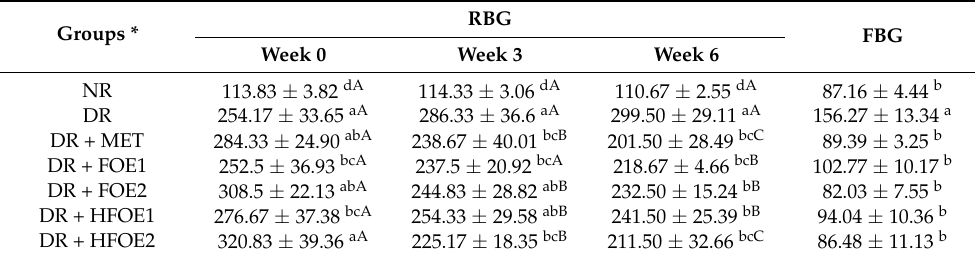
Table 4. Effect of orally administrated FOE and HFOE on RBG and FBG (mg dL − 1 ) in STZ-induced diabetes in rats (mean ± SE), n =